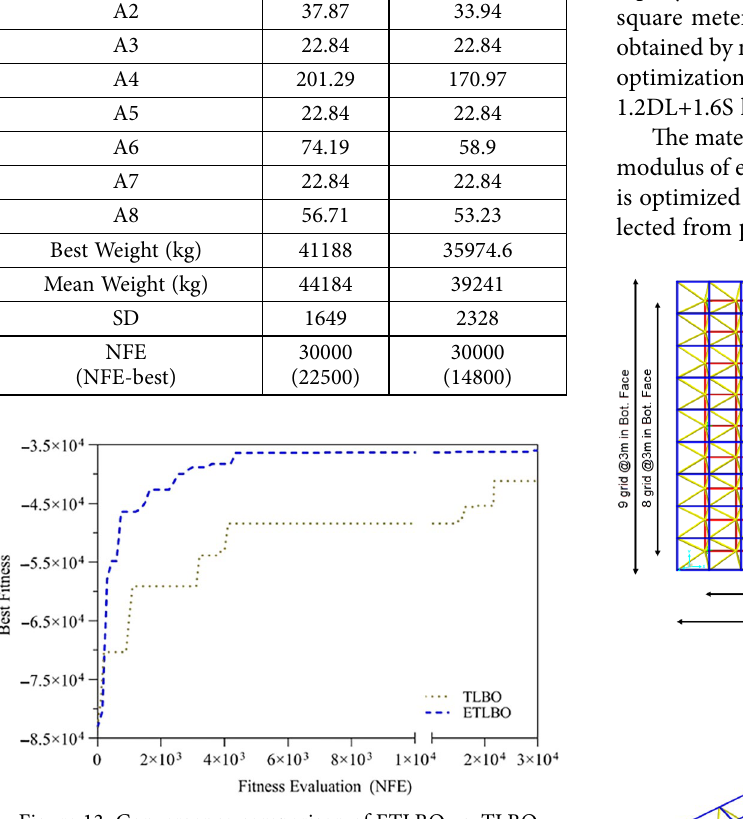
Figure 13. Convergence comparison of ETLBO vs. TLBO for the 112-bar truss example